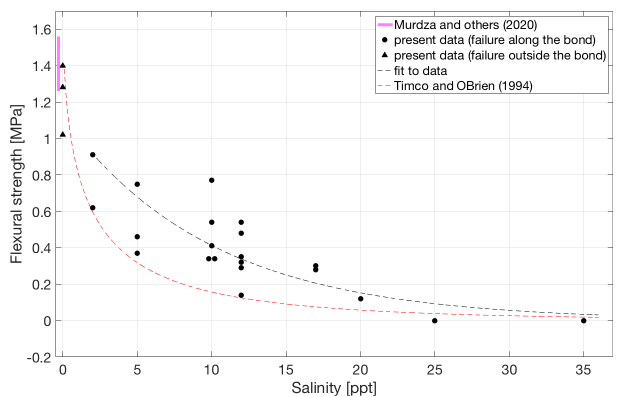
Figure 3. Flexural strength at − 3 ◦ C of bonded ice as a function of the salinity of the salt water from which the bond was formed. The solid pink line indicates the flexural strength 1.42 ± 0.16MPa of parent freshwater ice at − 3 ◦ C (Murdza et al., 2020b). A dashed red line is taken from Timco and O’Brien (1994) for the ice at − 3 ◦ C. A dashed black line is a fit to the present data.